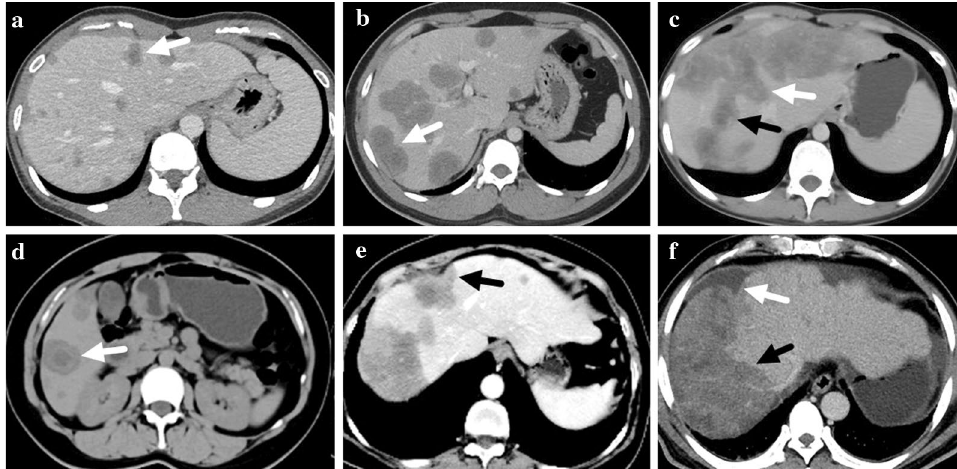
Fig. 2 a A nodular lesion with target sign was marked with a white arrow. b A locally coalescent lesion with target sign was marked with a white arrow. c A diffusely coalescent lesion occupied multiple liver segments (marked with a white arrow). Target sign could also be found in the lesion (marked with a black arrow). d Target sign could be found on unenhanced CT scan (marked with a white arrow). f Capsular retraction caused by a subcapsular lesion could be detected (marked with a black arrow). e A diffusely coalescent lesion (marked with a black arrow) was accompanied with capsular retraction and perihepatic effusion (marked with a white